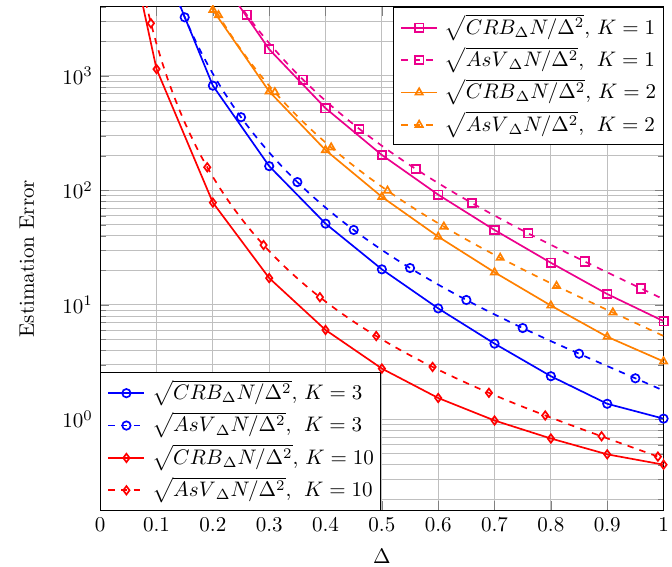
Figure 2. Sqrt-normalized CRB ∆ and AsV ∆ as a function of ∆ , for different values of K